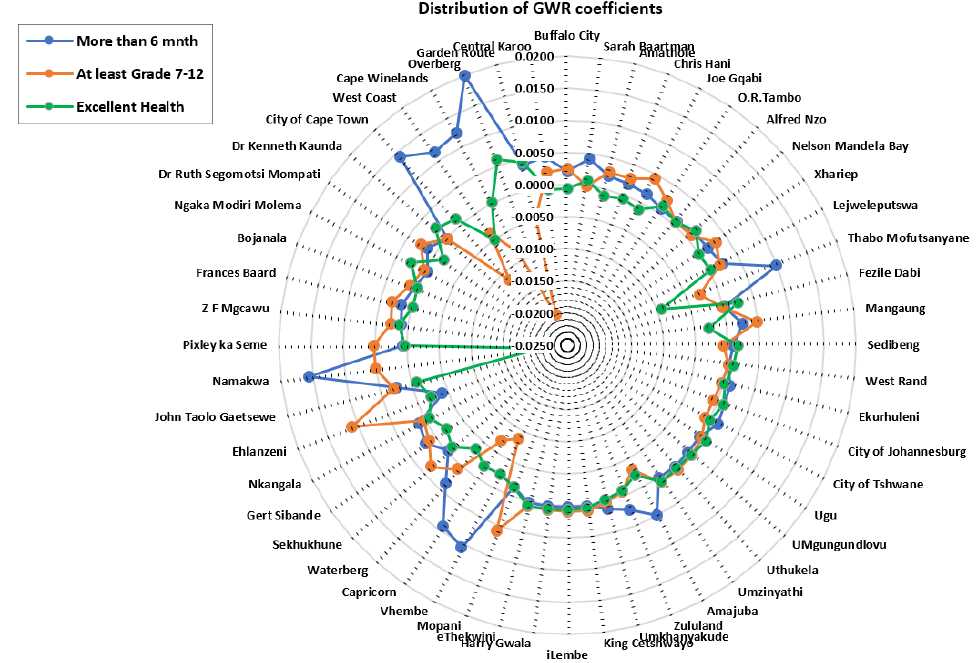
Figure 5. Spatial distribution of coefficients derived from the GWRP model.